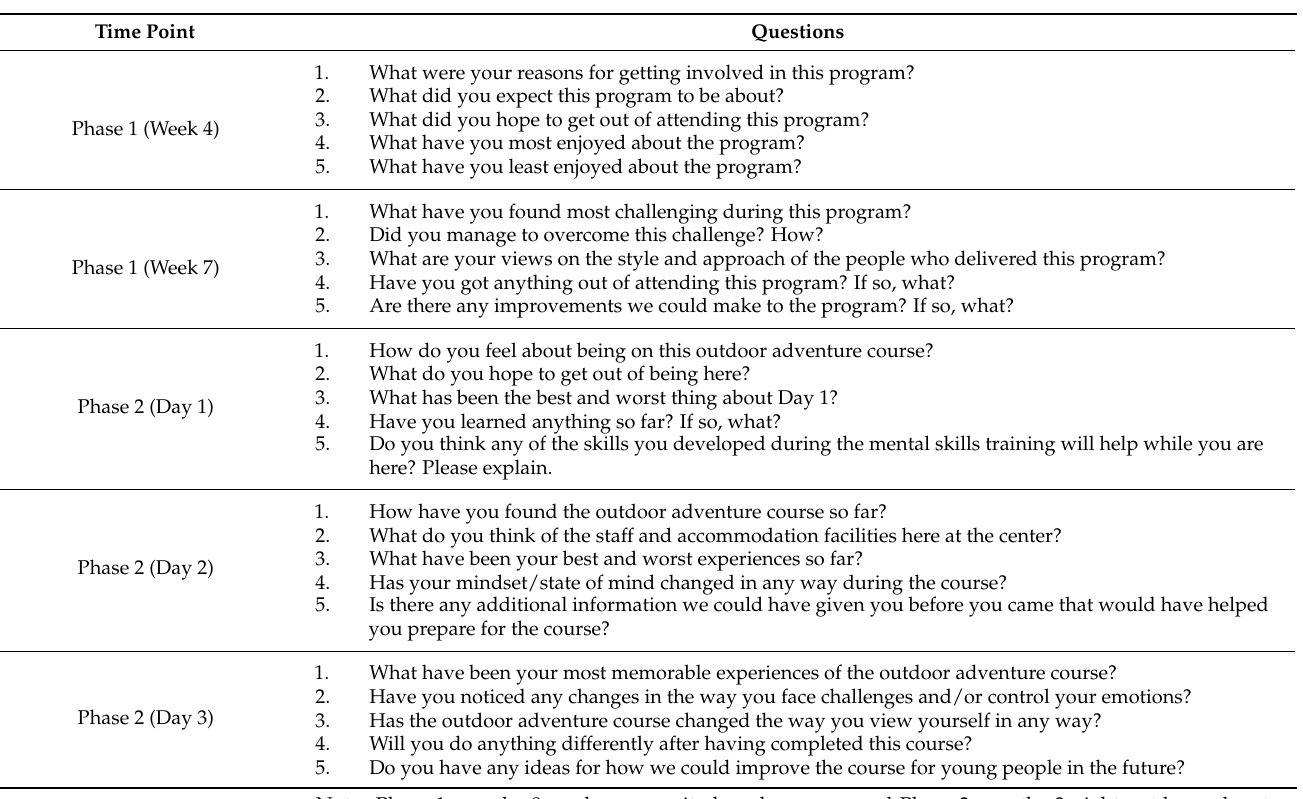
Table 2. Diary room